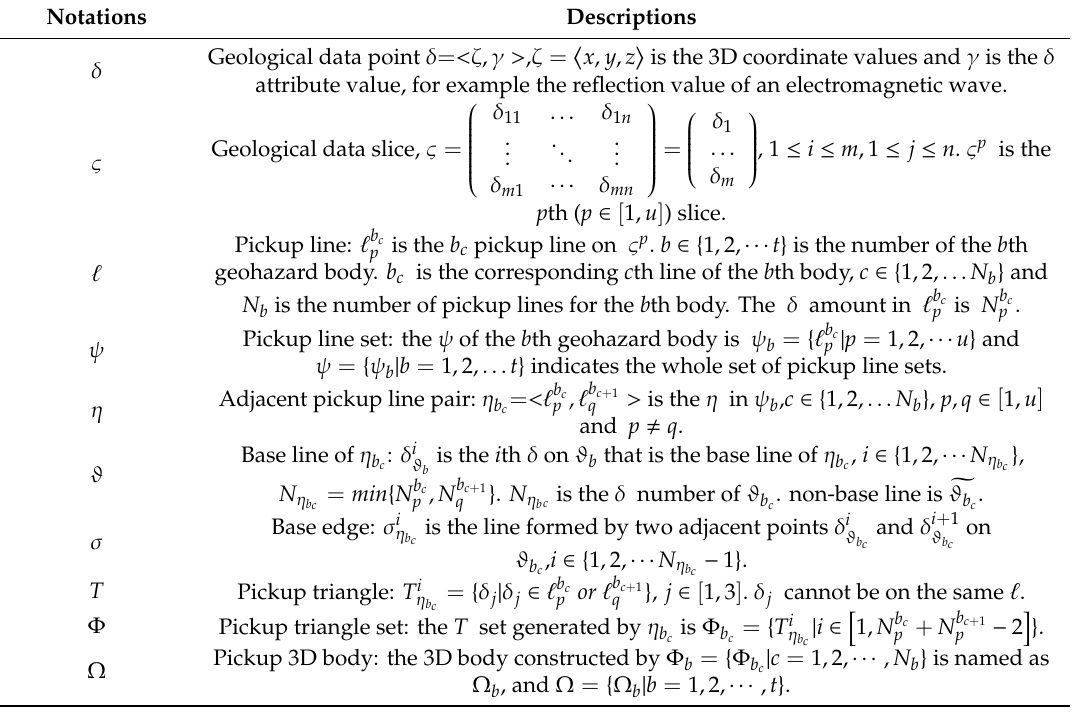
Table 1. Basic conceptions in the LC-TIN